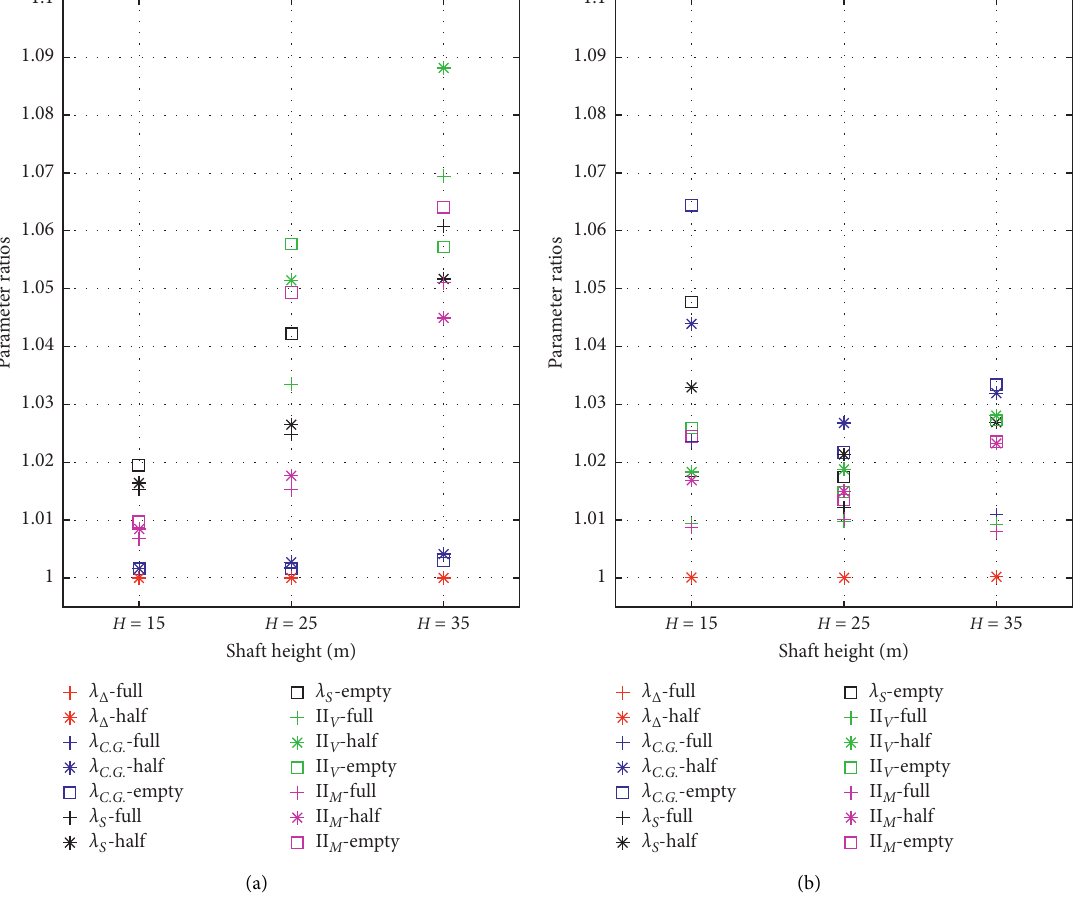
Figure 24: Maximum ratios of various response parameters under the assumed lateral load combinations (seismic+wind/seismic). (a) C1 RI at the base. (b) C2 RI under the